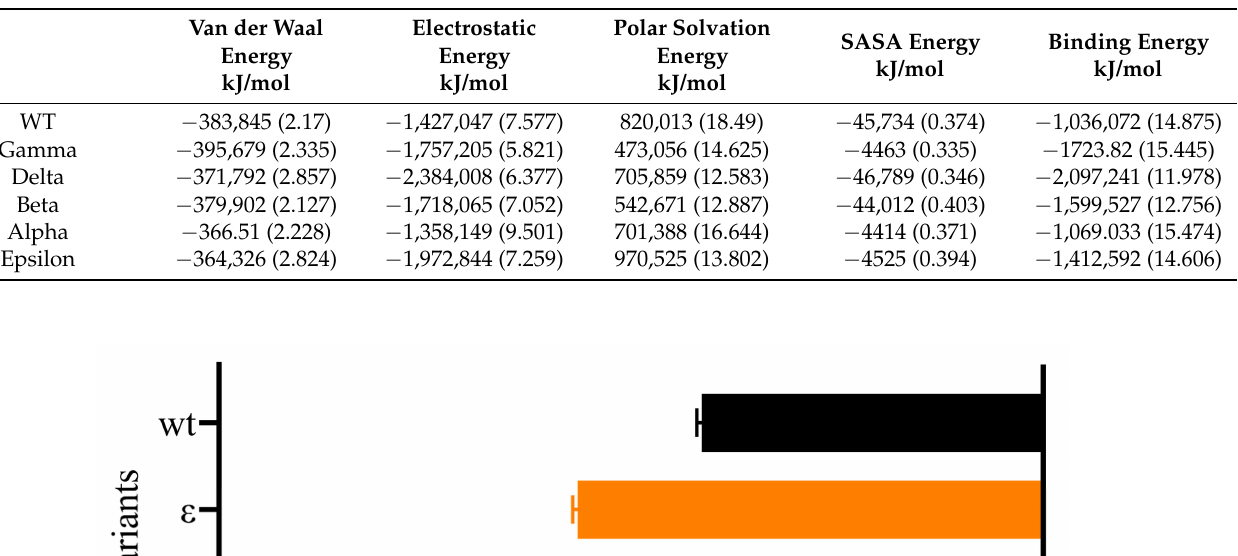
Table 4. MMPBSA free-energy analysis of S-protein variants and hACE2 binding.